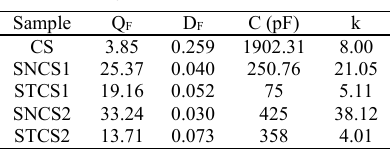
Table 6. Q , D , C and k of nanocomposites are obtained by F F using GPS 132 A (f = 1 KHz)